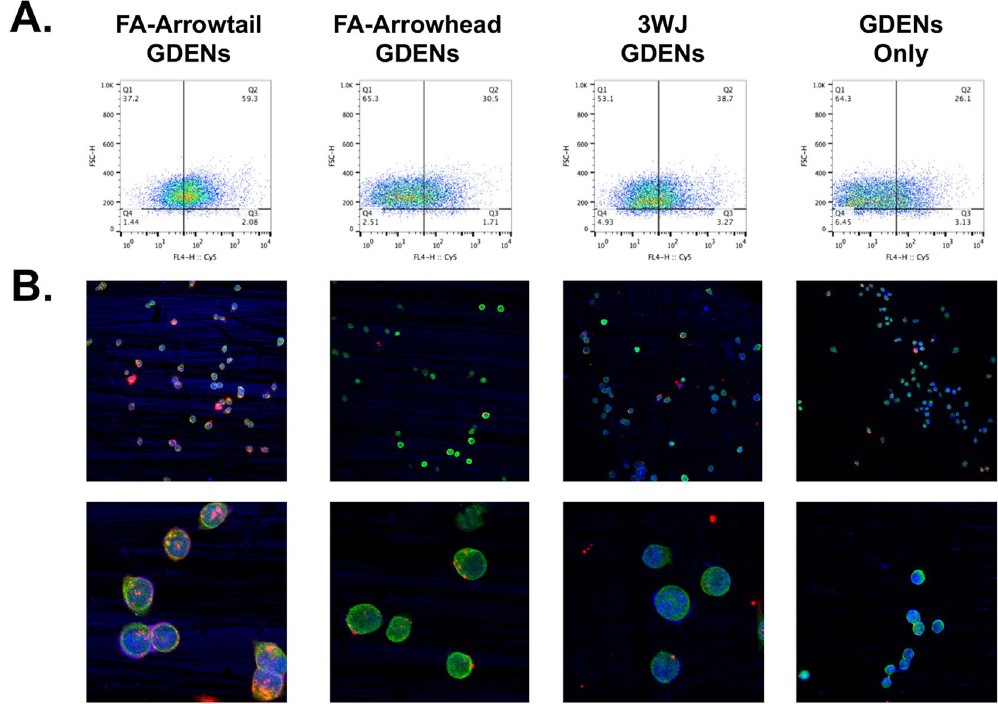
Figure 6. Cell binding and uptake of the arrowtail RNA ligand-displaying GDENs. ( A ) Flowcytometry and ( B ) confocal microscopy imaging compare binding and uptake of GDENs engineered by FA-pRNA-3WJ arrowtail and arrowhead to folate receptor overexpressed KB cells. Nucleus (blue), cytoplasm (green) and Alexa 647 labeled RNA loaded in GDENs (red)